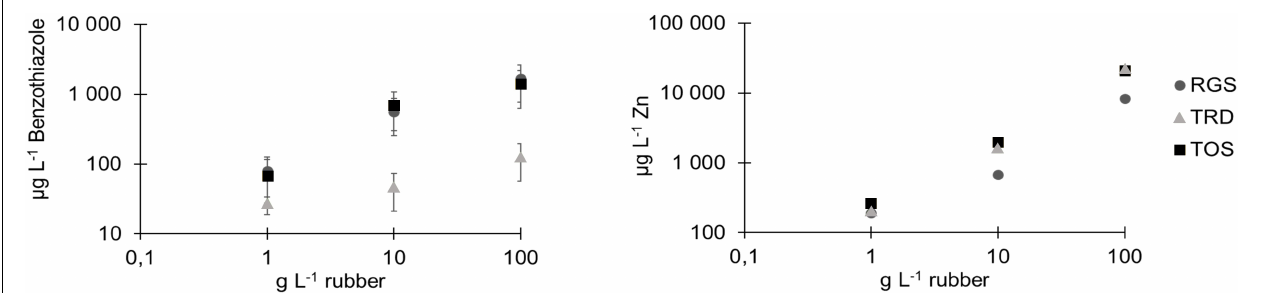
FIGURE 3 | Increasing concentrations of benzothiazole (left) and zinc (right) in seawater leachates ( µ g L − 1 ) as a function of CRG concentration. The graphs show averages and standard deviations for 3 replicates of leachate produced from ‘pristine’ CRG (RGS), pre-use CRG (TOS) and field collected CRG from a football field